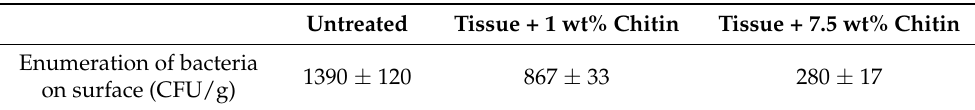
Table 3. Results for bacteria enumeration on tissues treated with ChNFs (percentage of chitin was referred to the weight of raw